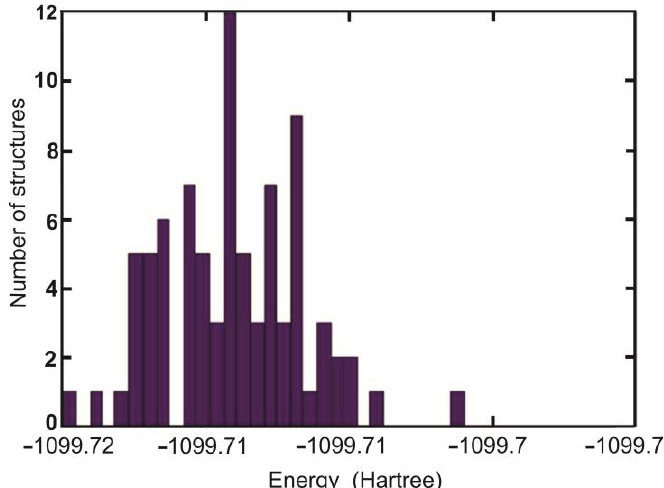
Figure 8. Energy distribution of EDTA apo structures optimized with BHANDHLYP/6-311 + G(d,p)/IEF-PCM method.